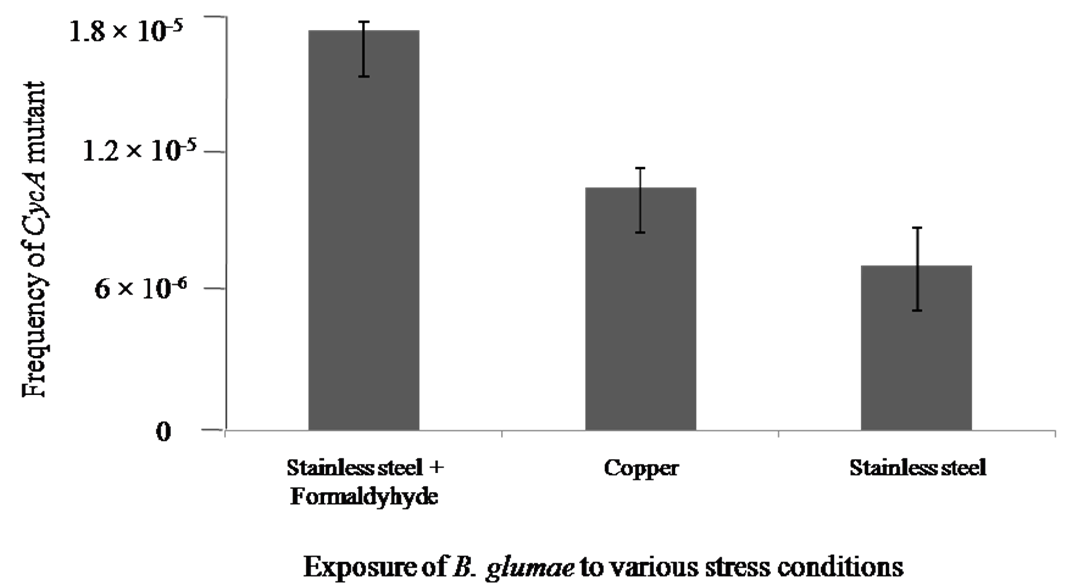
Figure 2. The frequencies of cycA mutants in B. glumae strains exposed to metallic copper, stainless steel, or stainless steel in the presence of formaldehyde,